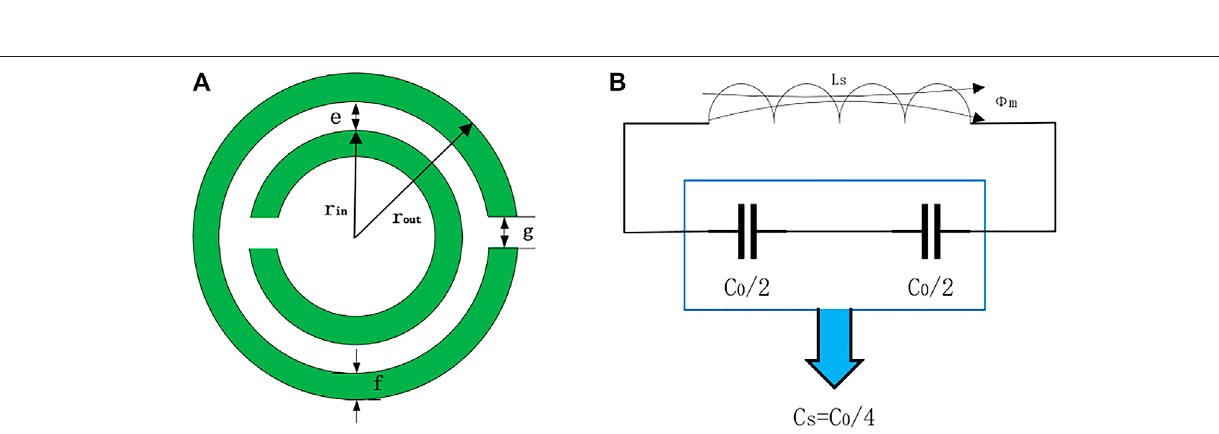
Frontiers in Physics |